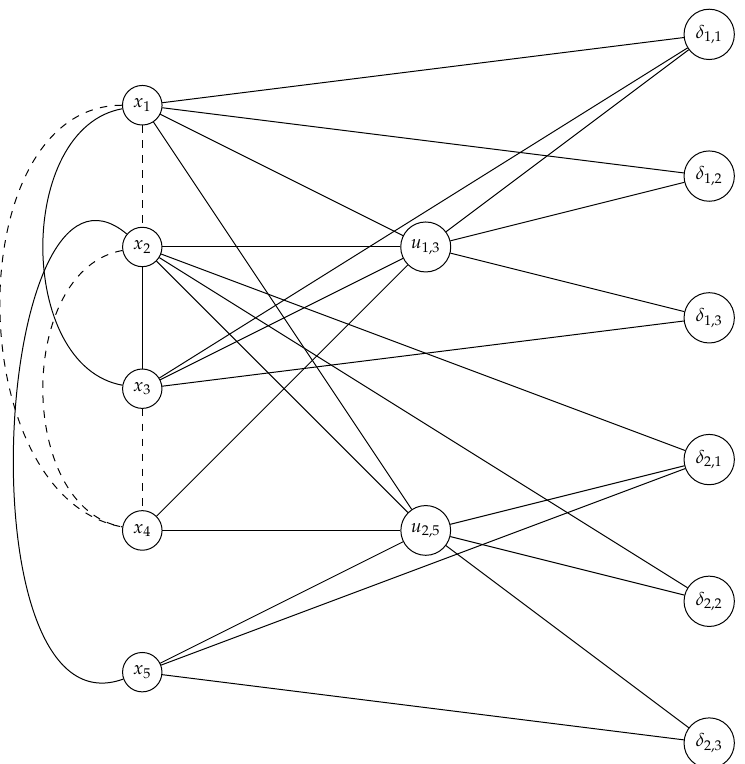
Figure 6. The derived graph for solving Example 1 using GVS with substitutions x 1 x 3 = u 1,3 and x 2 x 5 = u 2,5 . The vertices of this graph are the variables from the problem, x i for i the substitution variables, u 1,3 and u 2,5 , and the three δ c , k variables needed per substitution. The solid edges correspond to the edges induced by the substitution, which correspond to products of two monomials in the Equations (12)–(14). The dashed edges represent the two variable terms from the expansion of the 3-SAT clauses that are not involved in substitutions. The maximum degree of this graph is 8, thus the unitary circuit depth for one layer of QAOA is 9 or